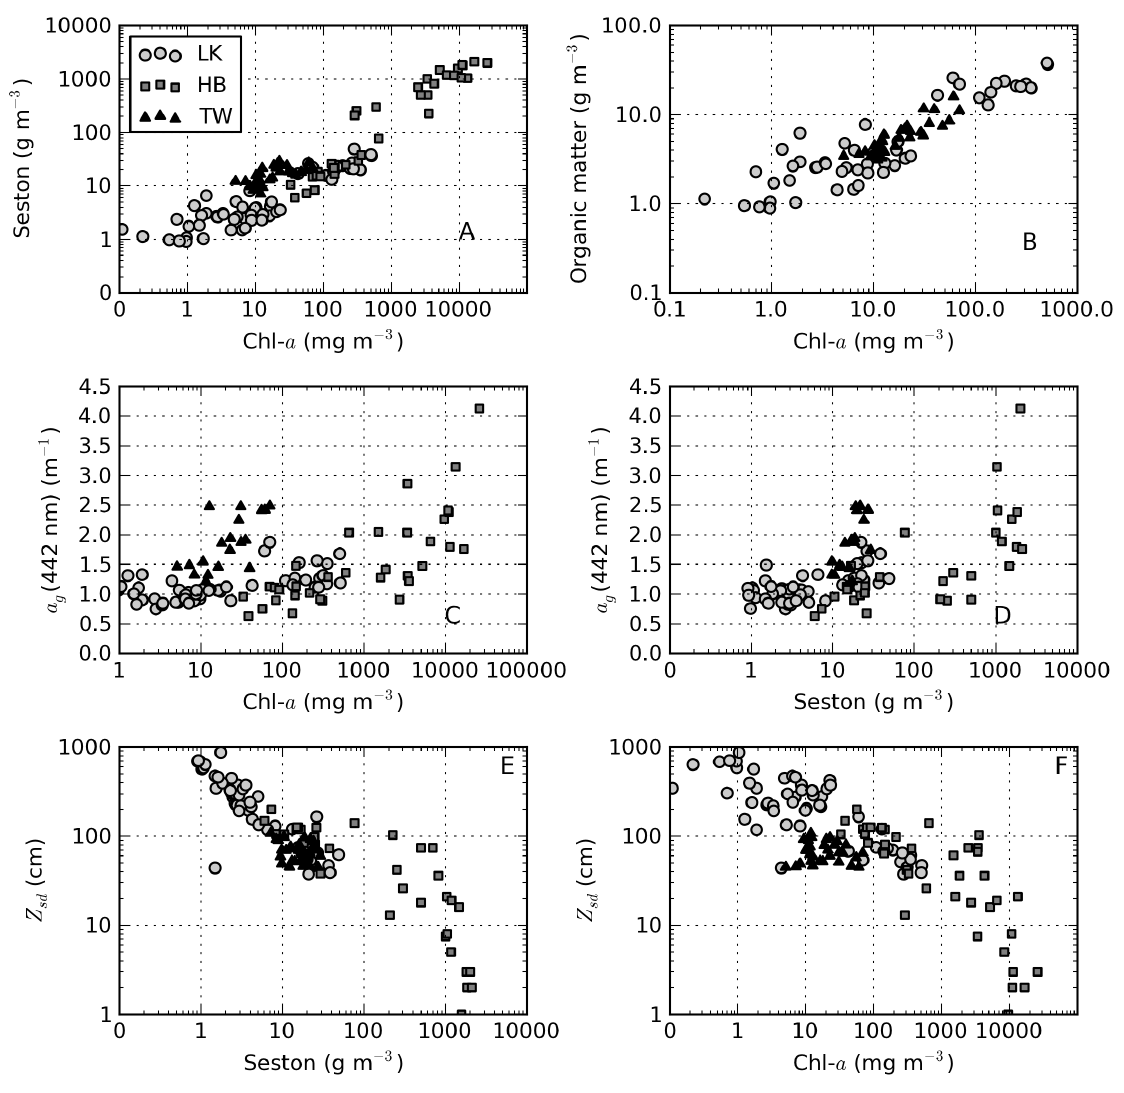
Figure 2. Scatter plots for ( A ) seston versus chl- a ; ( B ) organic matter versus chl- a ; ( C ) a (442) versus chl- a ; ( D ) a g chl- a . Note logarithmic scales.